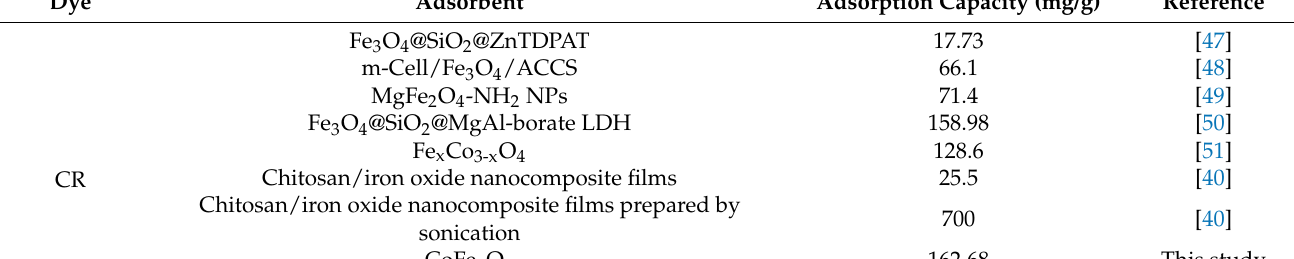
Table 3. Adsorption capacities of different magnetic adsorbents from the literature for the removal of CR and MO.